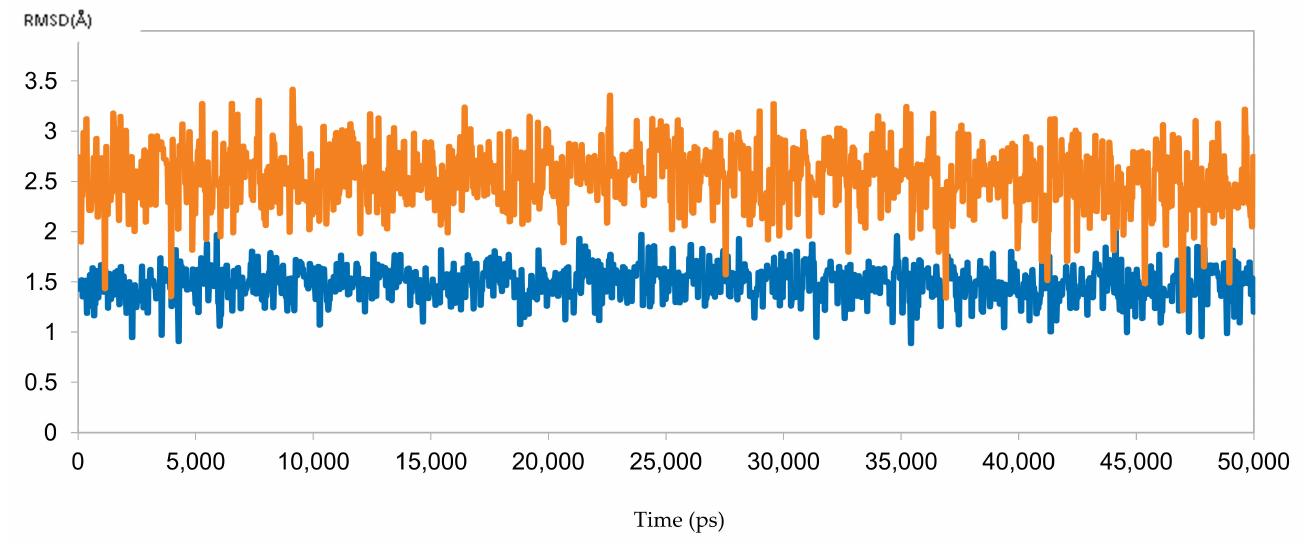
Figure 10. The RMSD of two dynamic simulations of sofosbuvir in complex with HCV 4a NS5B, comparing responder sample 10 (blue) and resistant sample 3